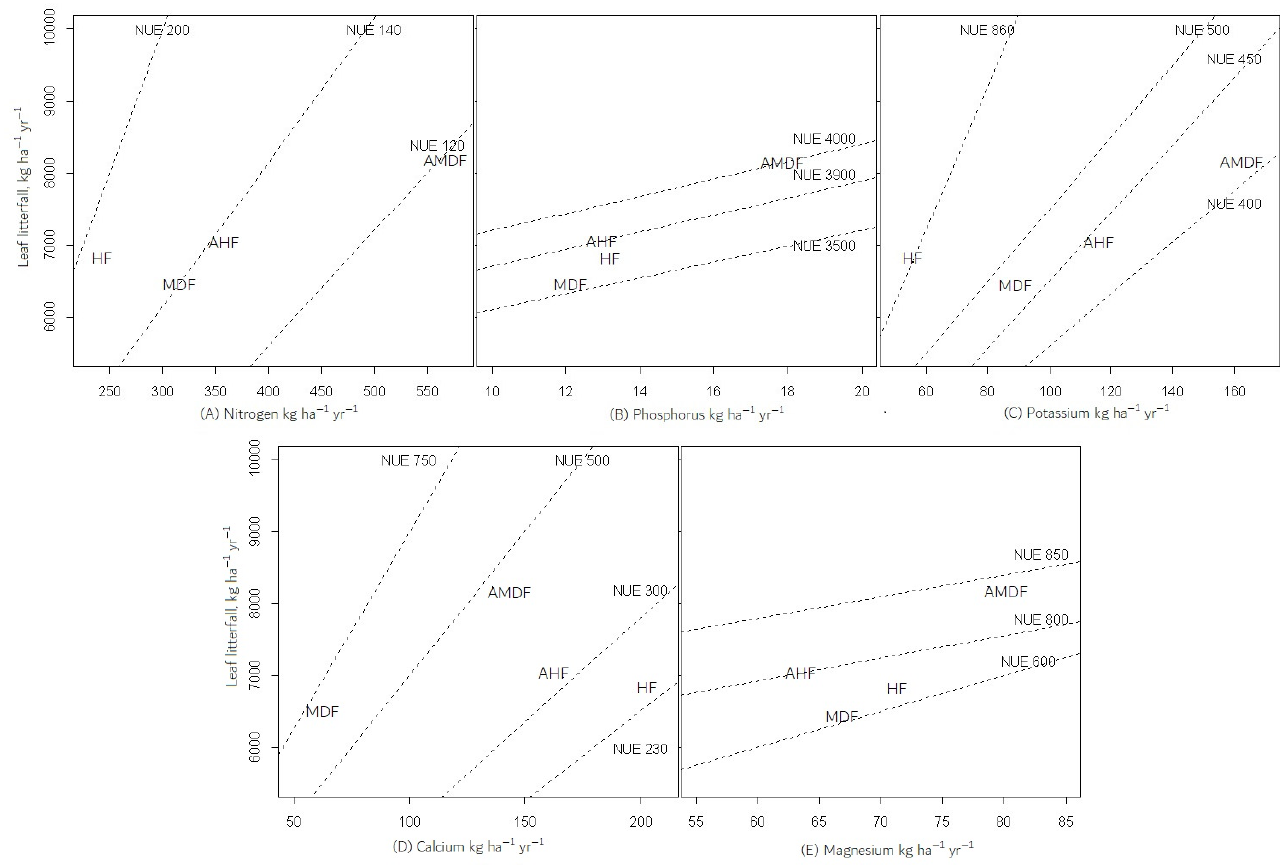
Figure 2. The relationship between the dry mass of leaf litterfall production (kg ha − 1 yr − 1 ) and nutrient returns for ( A ) nitrogen (N), ( B ) phosphorus (P), ( C ) potassium (K), ( D ) calcium (Ca), and ( E ) magnesium (Mg) through leaf litterfall production (kg ha − 1 yr − 1 ) for intact heath forest (HF), Acacia-invaded heath forest (AHF), intact mixed dipterocarp forest (MDF), and Acacia-invaded mixed dipterocarp forest (AMDF). Dotted lines indicate constant stand-level nutrient use efficiency (NUE).